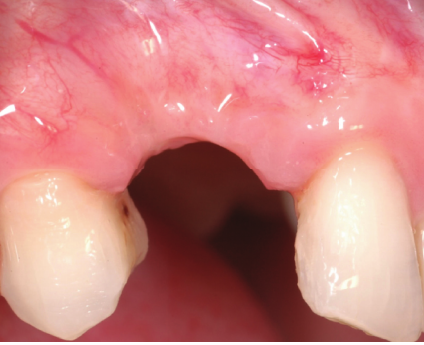
Figure 1: Clinical view of the lateral aspect of the edentulous site.